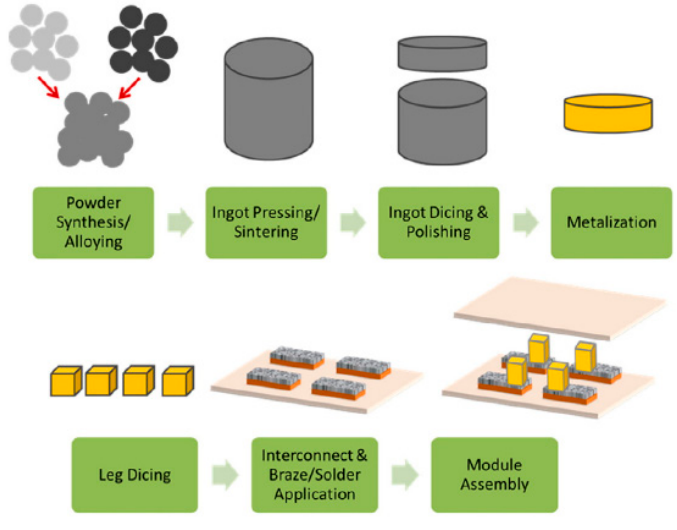
Figure 3. Typical manufacturing process of TEG [32] .